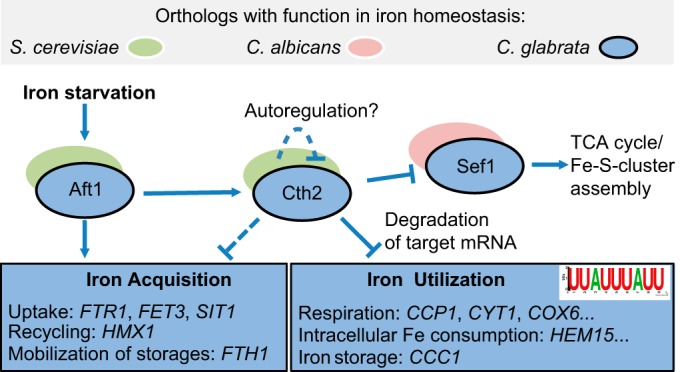
Model of iron metabolism regulation in C. glabrata. In C. glabrata (blue), similarly to S. cerevisiae (green), Aft1 acts as an activator of iron acquisition genes under iron starvation conditions (FTR1, FET3, SIT1), while it also induces expression of CTH2. Cth2, a mediator of posttranscriptional mRNA degradation, targets transcripts carrying the recognition motif 5′-UUAUUUAUU-3′, predominantly associated with iron consumption processes (HEM15, CCP1, ACO1). Additional postulated functions of Cth2 (dashed lines) also include the negative regulation of iron acquisition in a moderate manner and an autoregulatory role. The transcription factor SEF1, which is important in the C. albicans iron regulon (red), is also a Cth2 target gene in C. glabrata which has a specific impact on the TCA cycle and on iron sulfur cluster (Fe-S cluster) assembly.